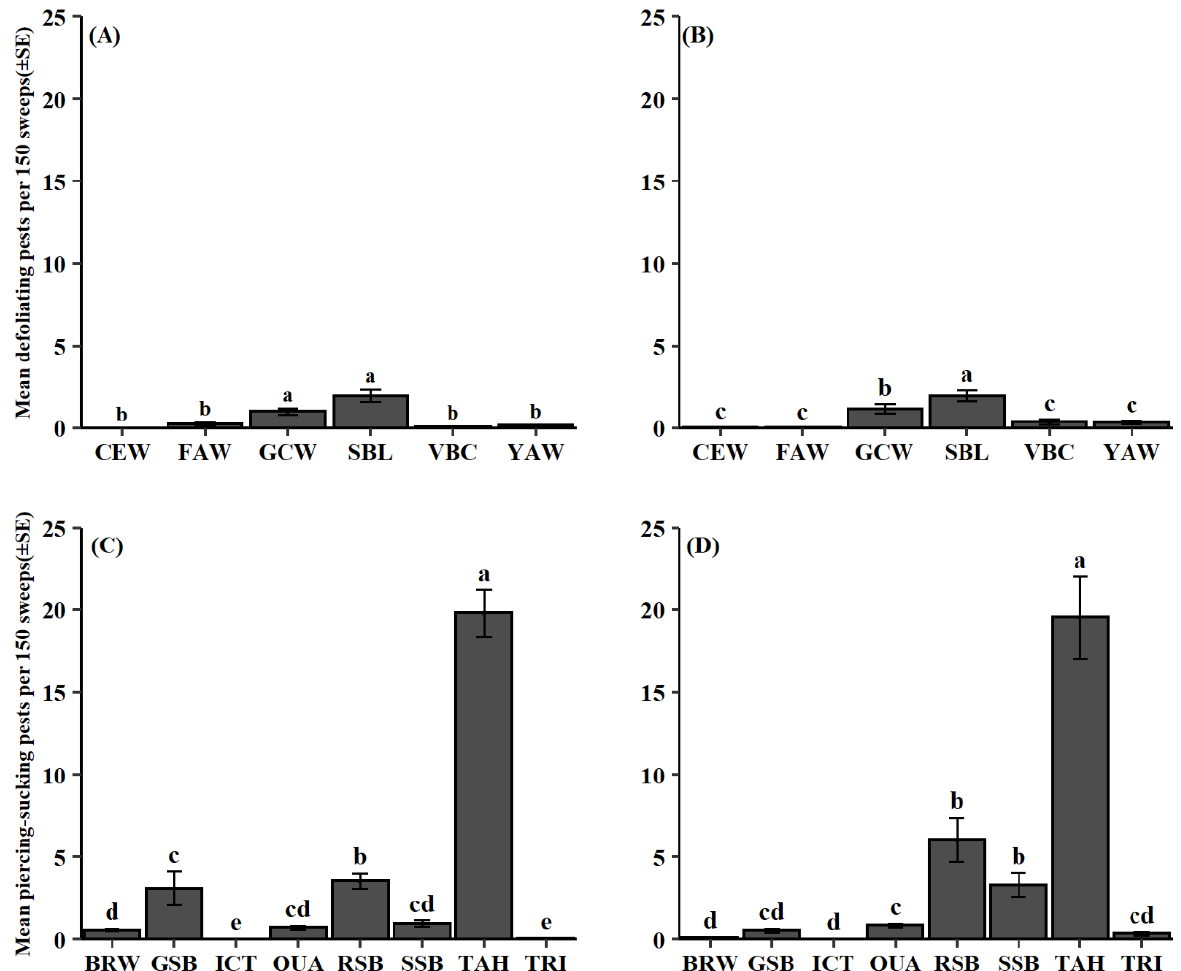
Figure 1. Mean pest count per 150 sweeps ( ± SE) for collected defoliating pest groups in datasets ( A ) 2012–2014 and ( B ) 2015–2018; piercing-sucking pest groups in datasets ( C ) 2012–2014 and ( D ) 2015–2018. Same letter denotes no significant difference between means ( p > 0.05). Abbreviations for defoliating pest groups: CEW = H. zea , FAW = S. frugiperda , GCW = H. scabra , SBL = C. includens , VBC = A. gemmatalis , YAW = S. ornithogalli ; piercing-sucking pests: BRW = E. servus , GSB = C. hilaris , ICT = E. ictericus , QUA = E. quadrator , RSB = P. guildinii , SSB = N. viridula , TAH = S. festinus , TRI = E. tristigmus .